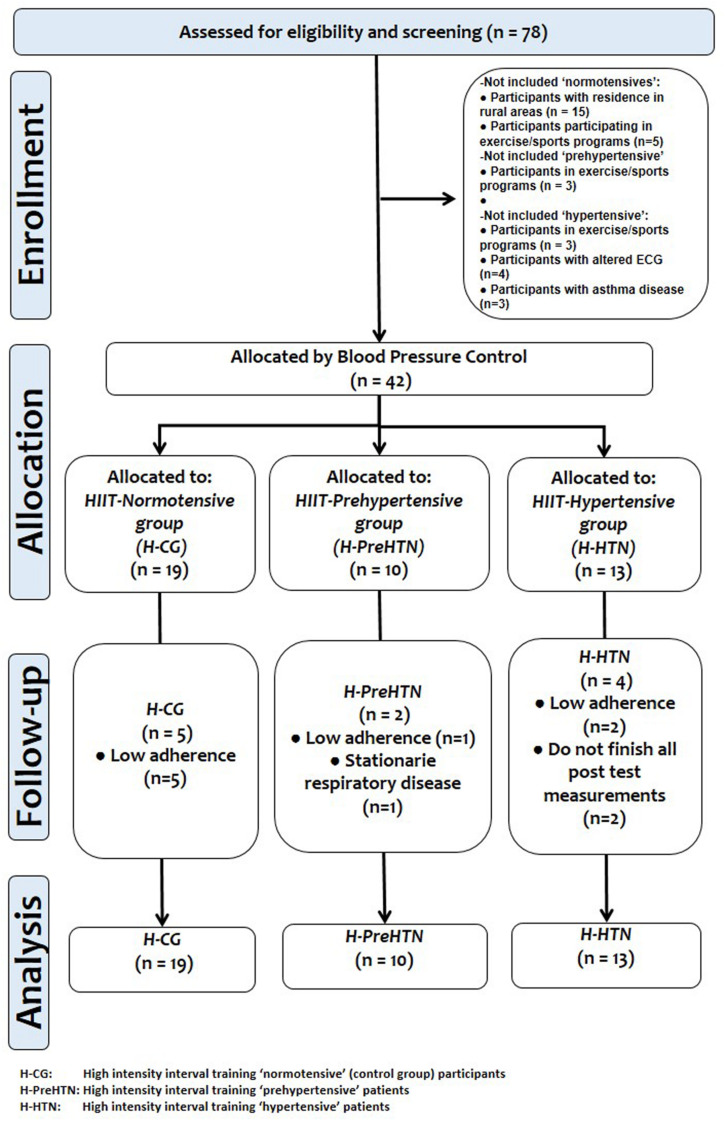
Flow-chart diagram.